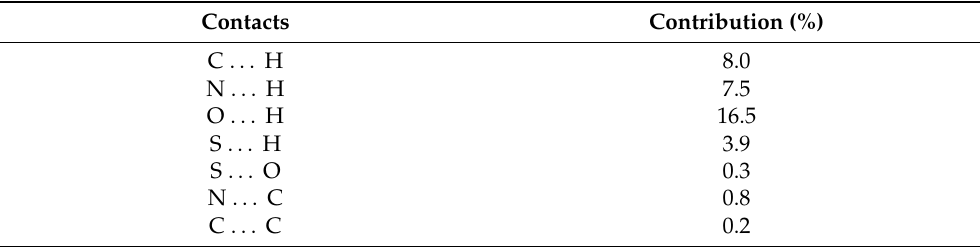
Figure 7. Fingerprint plots of ( a ) C . . . H, ( b ) N . . . H, ( c ) O . . . H, ( d ) S . . . H for 4 . Table 3. Percentage contributions of interatomic contacts to the Hirshfeld surface for 4